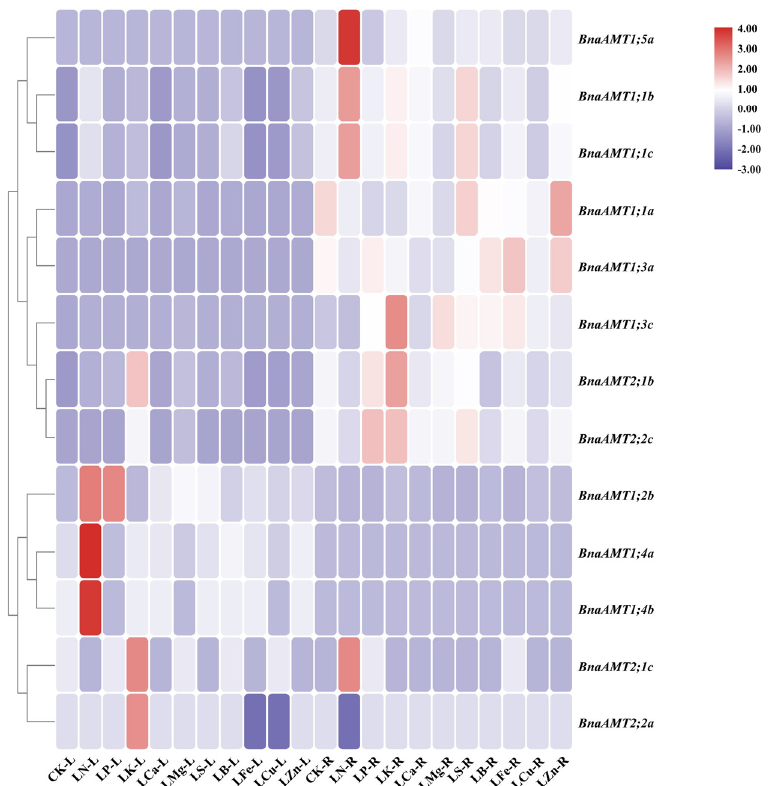
Figure 5. The relative expression profiles of BnaAMT family gene responses to different nutrient deficiencies. LN, N deficiency; LP, P deficiency; LK, K deficiency; LCa, Ca deficiency; LMg, Mg deficiency; LS, S deficiency; LB, B deficiency; LFe, Fe deficiency; LCu, Cu deficiency; LZn, Zn deficiency; CK, control. L, leaf; R, root. The red color indicates upregulation, while the blue color indicates downregulation. The relative expression levels of BnaAMTs were relative to the control ( actin 7 ). Four biological replicates were performed.